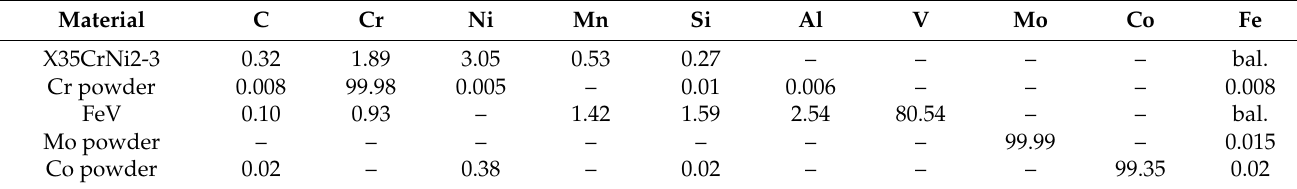
Table 1. Chemical composition of steel and the components of saturating mixtures, wt.